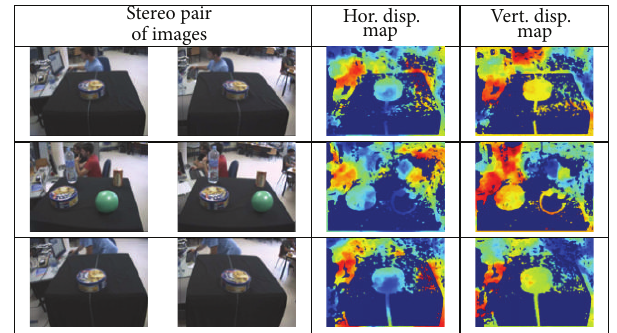
Figure 11: Disparity estimation results obtained on an STH-DCSG stereo head by applying the PBBDE approach when only horizontal disparity appears (first row), only vertical disparity is present (second row), and when both horizontal and vertical disparities appear (last row).